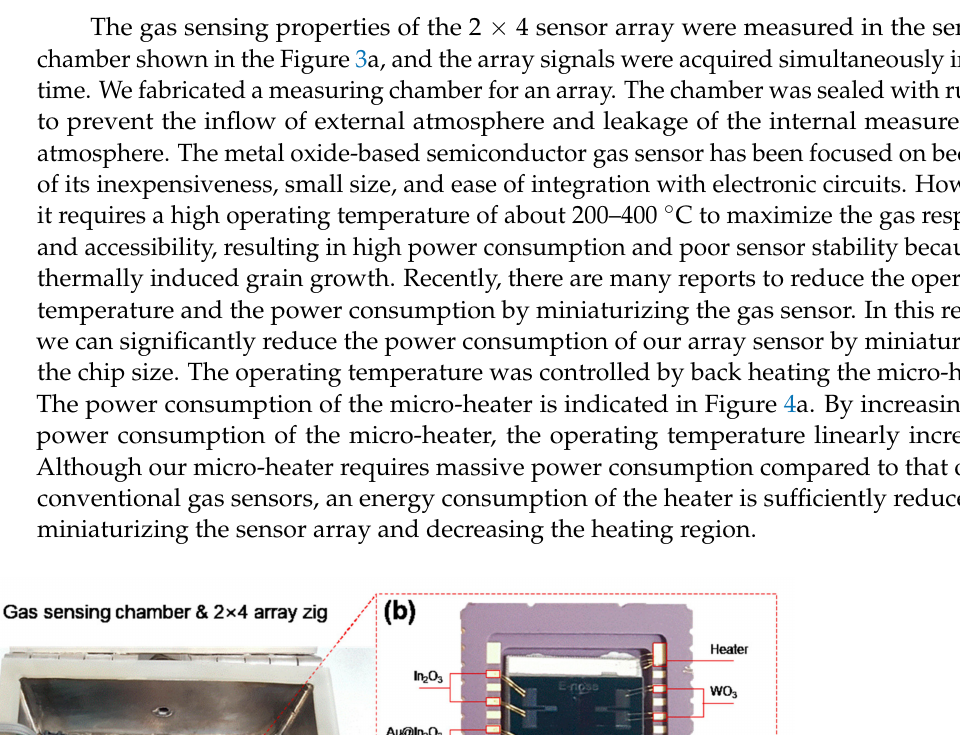
Figure 2. Top-view and cross-sectional (inset) FE-SEM images of ( a – d ) bare, Au-, Pt-, and Pd-decorated In 2 O 3 nanorods, ( f – i ) bare, Au- (2 nm), Pt- (1 nm), and Pd- (2 nm) decorated WO 3 nanorods. X-ray diffraction pattern of ( e ) In 2 O 3 and ( j ) WO 3 nanorods as a function of decorated catalysts.